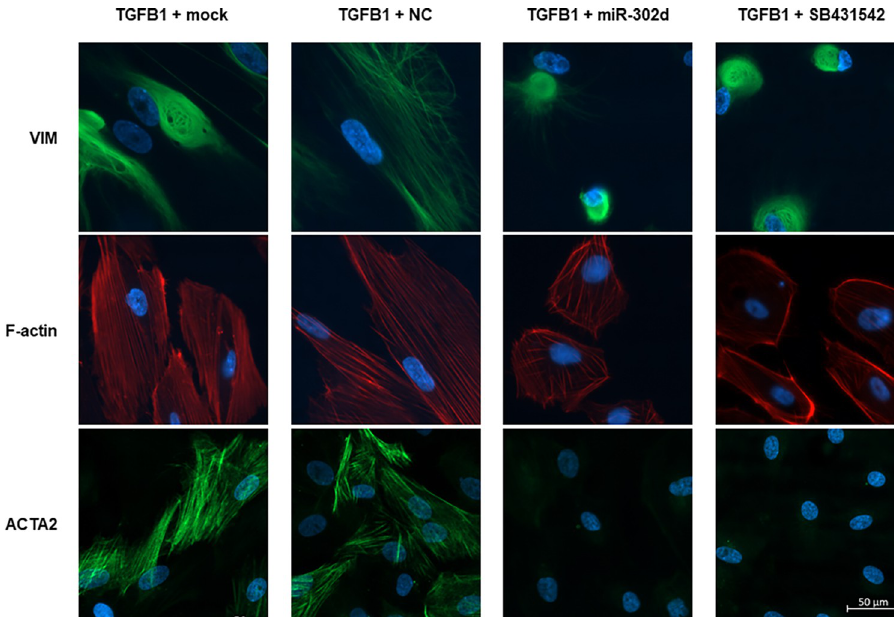
Fig 7. miR-302d reverts TGFB-induced EMT in hRPE cells. hRPE cells were incubated with TGFB1 for 4 d to achieve a mesenchymal state. Cells were then transfected with mock, NC, miR-302d, or exposed to SB431542. ICC staining for VIM, F-actin, and ACTA2 was performed 3 d post-transfection. The scale bar represents 50 μ m.